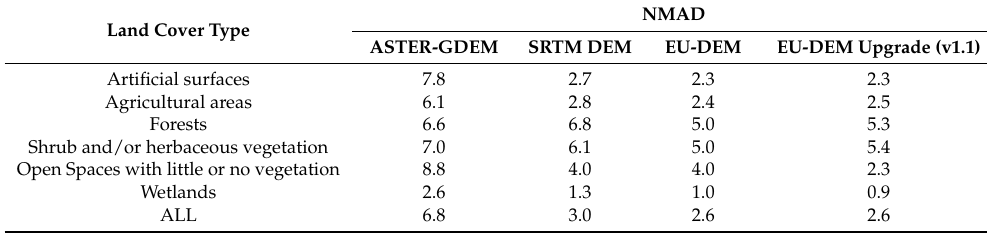
Figure 10. Normalized Median Absolute Deviation (NMAD) of absolute elevation errors plotted against different land cover classes. Table 4. Normalized Median Absolute Deviation (NMAD) of absolute elevation error values per land cover.